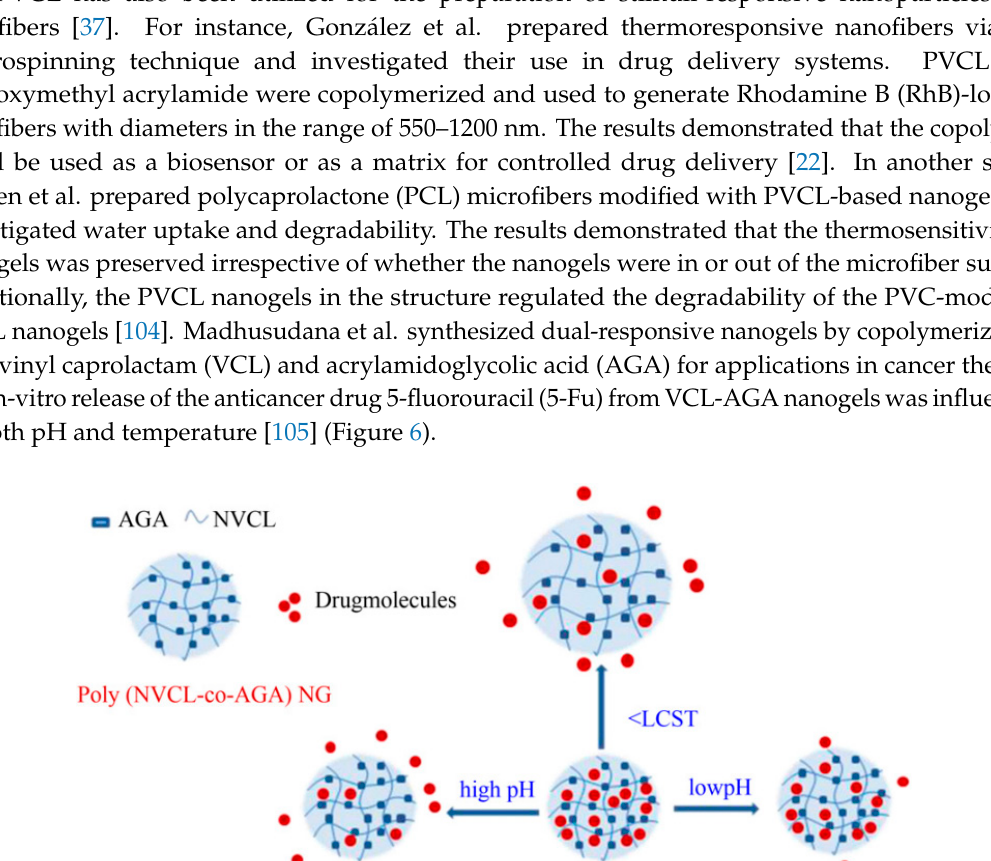
Table 1. Components and applications of investigated thermosensitive nanogels containing polymers bearing amide groups. “ ‐ “ means there is no therapeutic agent introduced in the reference paper and only thermosensitive drug carrier was synthesized and prepared.